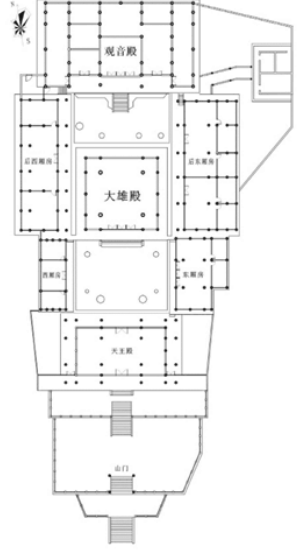
Figure 2 Bao Fan Temple